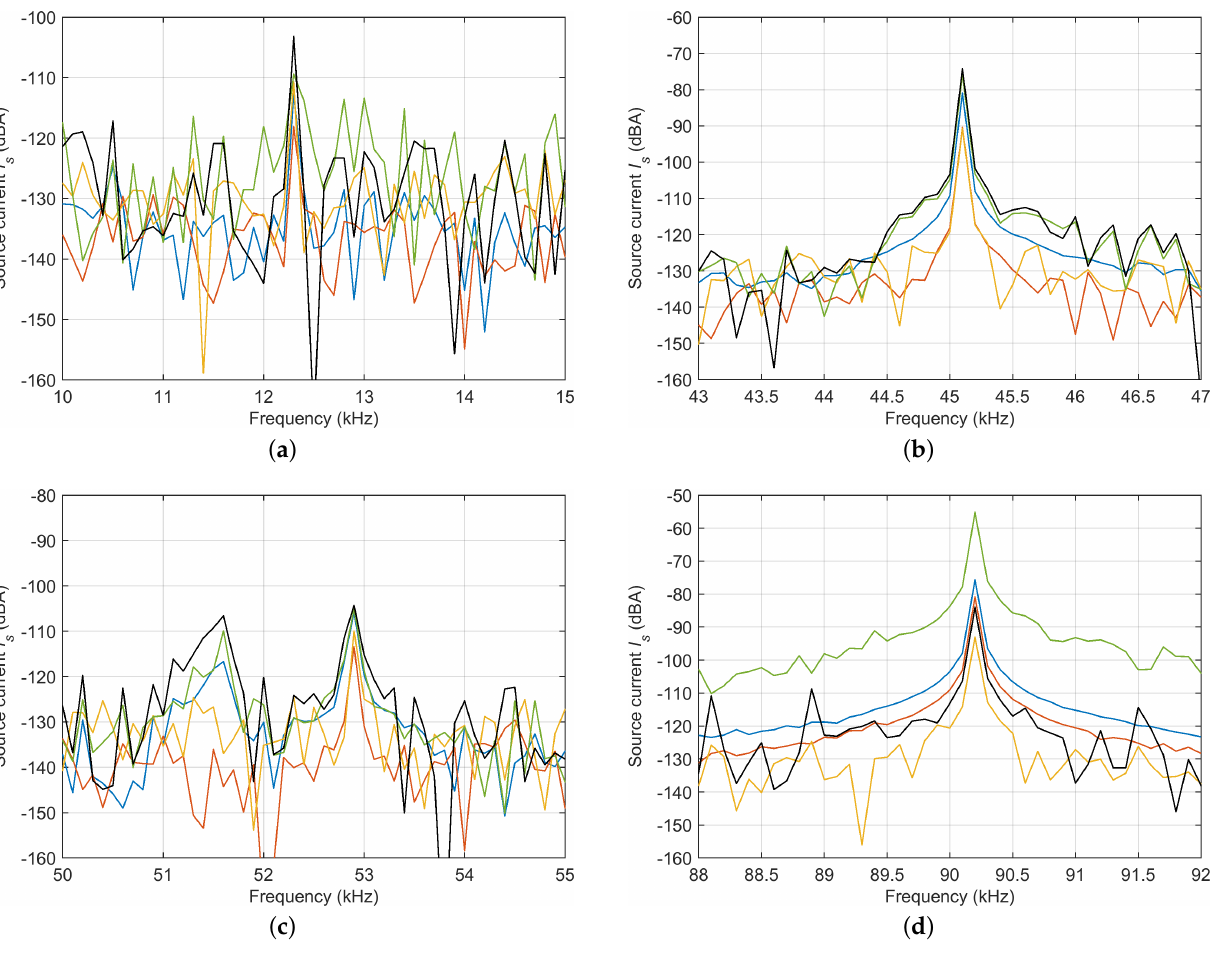
Figure 8. Details of spectral components undergoing extrapolation of measured I s current to the 0 Ω condition: ( a ) 12.3kHz, ( b ) 45.1kHz, ( c ) 51.6kHz and 52.9kHz, ( d ) 90.2kHz. Curves refer to LISN 0.2 Ω (blue), LISN 0.6 Ω (dark orange), LISN 0.2ohm+10µH (dark yellow), extrapolated to 0 Ω with separated real and imaginary parts (green) and with absolute value (black), as in Figure 7.